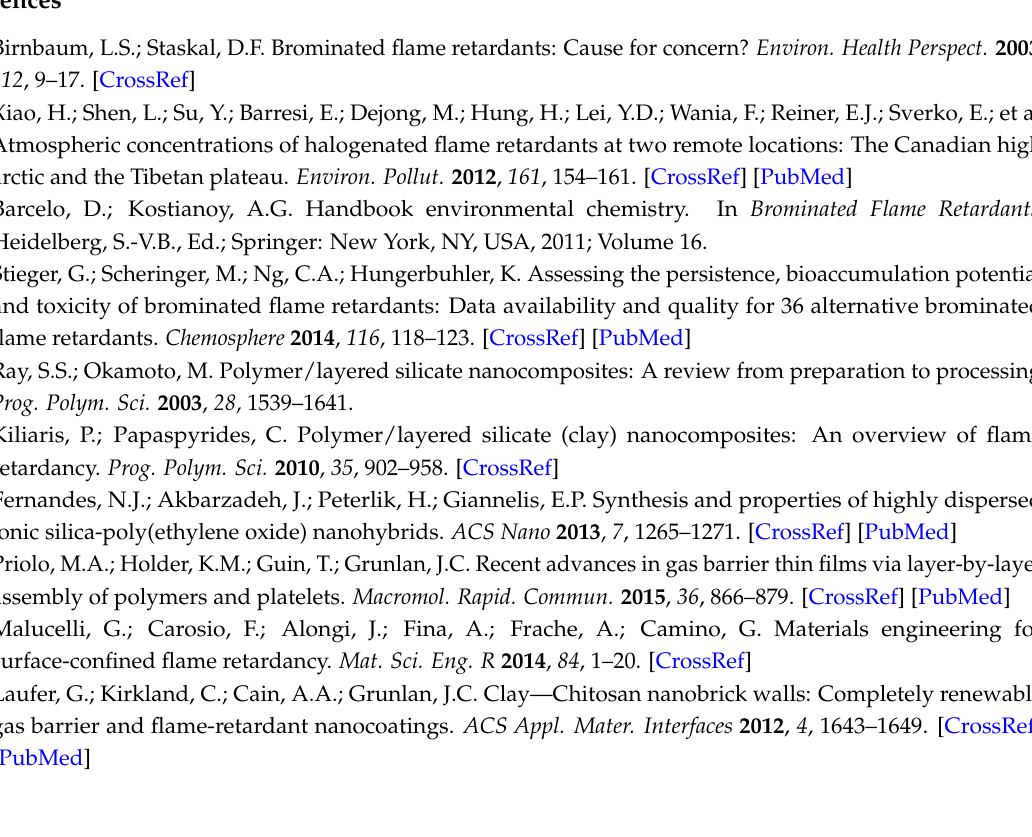
Figure S1: Images of MTM (a), APP (b) and mixture of APP/MTM (c) after irradiation under 35 kW/m 2 heat flux in a cone calorimeter. Figure S2: FE-SEM micrographs of defects in 2.5% APP/MTM samples. Figure S3: EDS analyses performed on 2.5% APP/MTM and 5% APP/MTM samples. Figure S4: Images of residues collected at the end of cone calorimetry tests: (a) untreated cotton, (b) 2.5% APP/MTM and (c) 5% APP/MTM samples. Figure S5: EDS analyses performed on 5% APP/MTM residues collected at the end of cone calorimetry